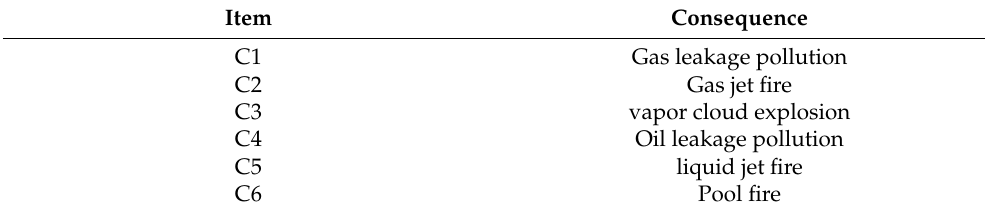
Table 5. BT model accident escalation